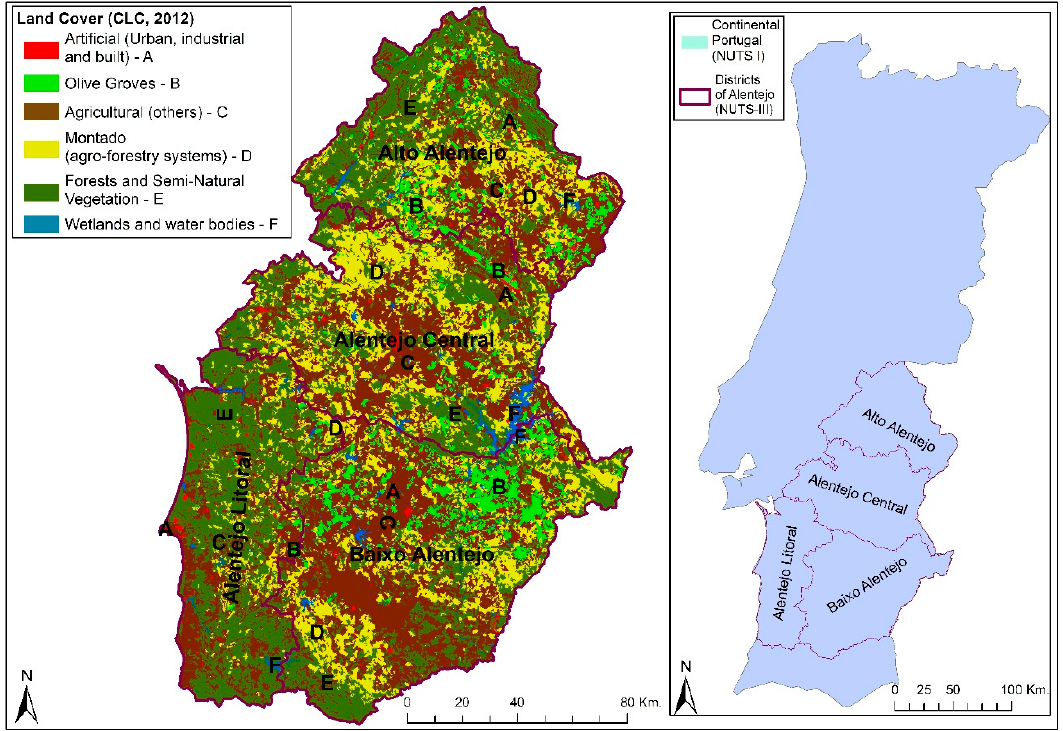
Figure 1. Location and key land cover classes of the case study area (own elaboration, based on CLC (Corine Land Cover) [28]).